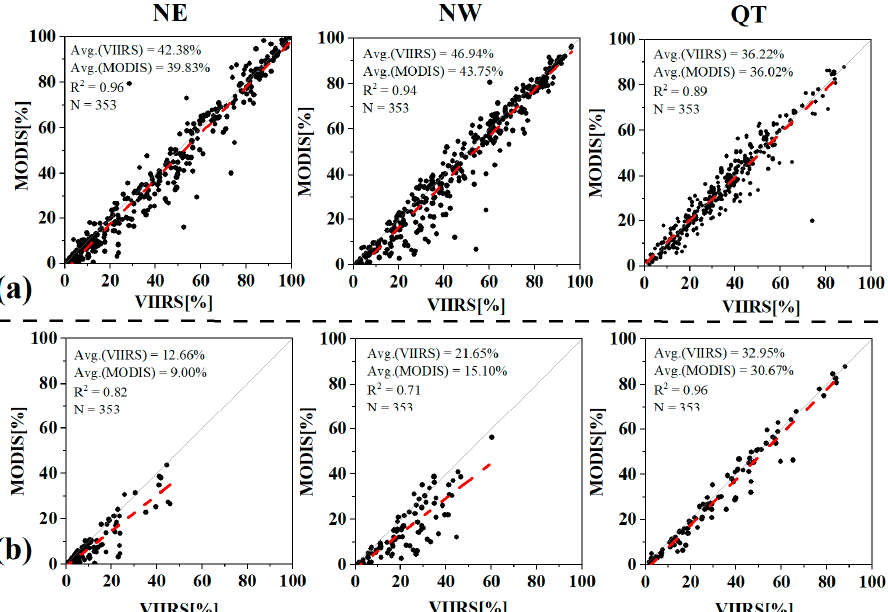
Figure 6. Scatter plots of daily no snow/no cloud cover percentage in three test regions illustrating VIIRS with respect to MODIS in ( a ) the entire hydrological year and ( b ) the snow season. Each column represents the results in the NE, NW and QT regions from left to right. Avg. (VIIRS) represents the average percentage of no snow/no cloud cover in VIIRS and Avg. (MODIS) represents the average percentage of no snow/no cloud cover in MODIS. The red line is the fitting line with the coefficient of determination (R2), and N is the number of days.